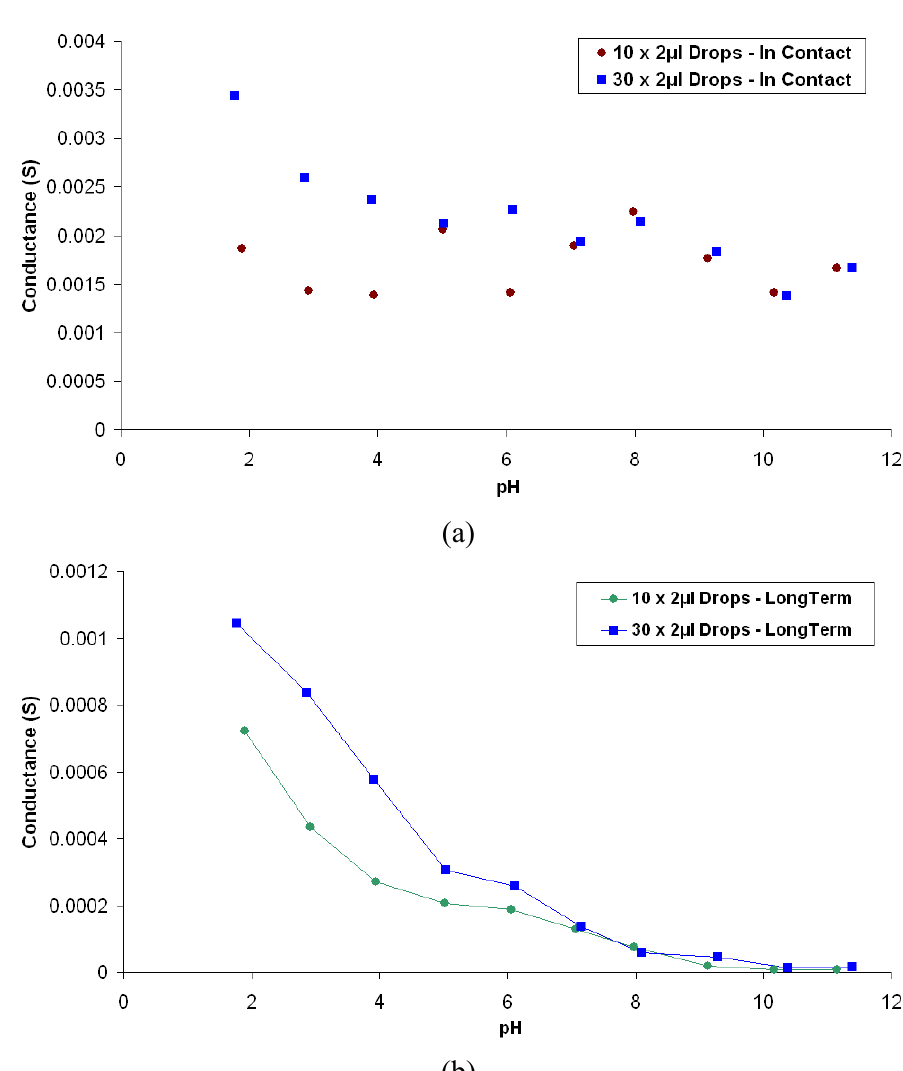
Figure 9. Plots showing the change in conductivity of PANI composite films when films are: (a) in contact with the test solution; and (b) after rinsing in de-ionised water and drying, showing long term effects of solution pH on film